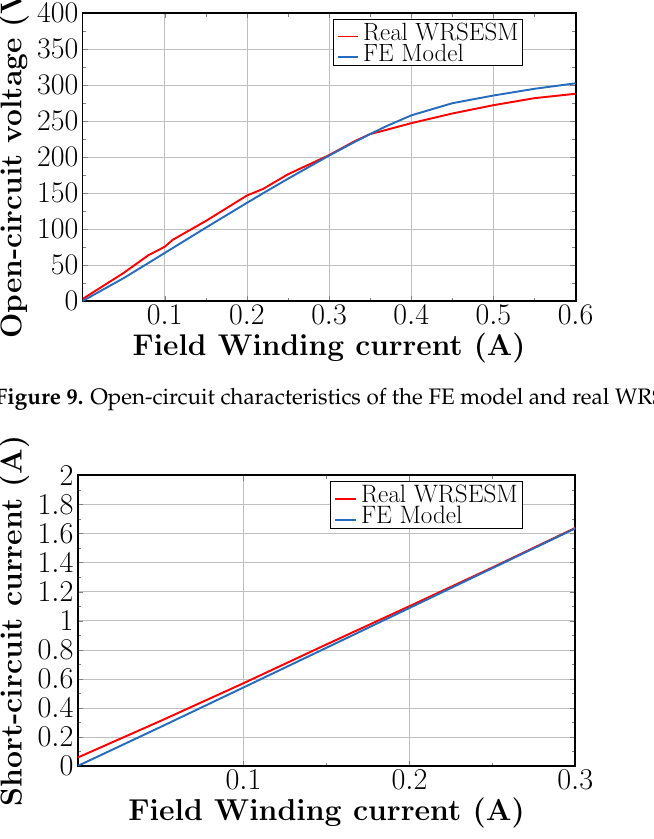
Figure 10. Short-circuit characteristics of the FE model and real